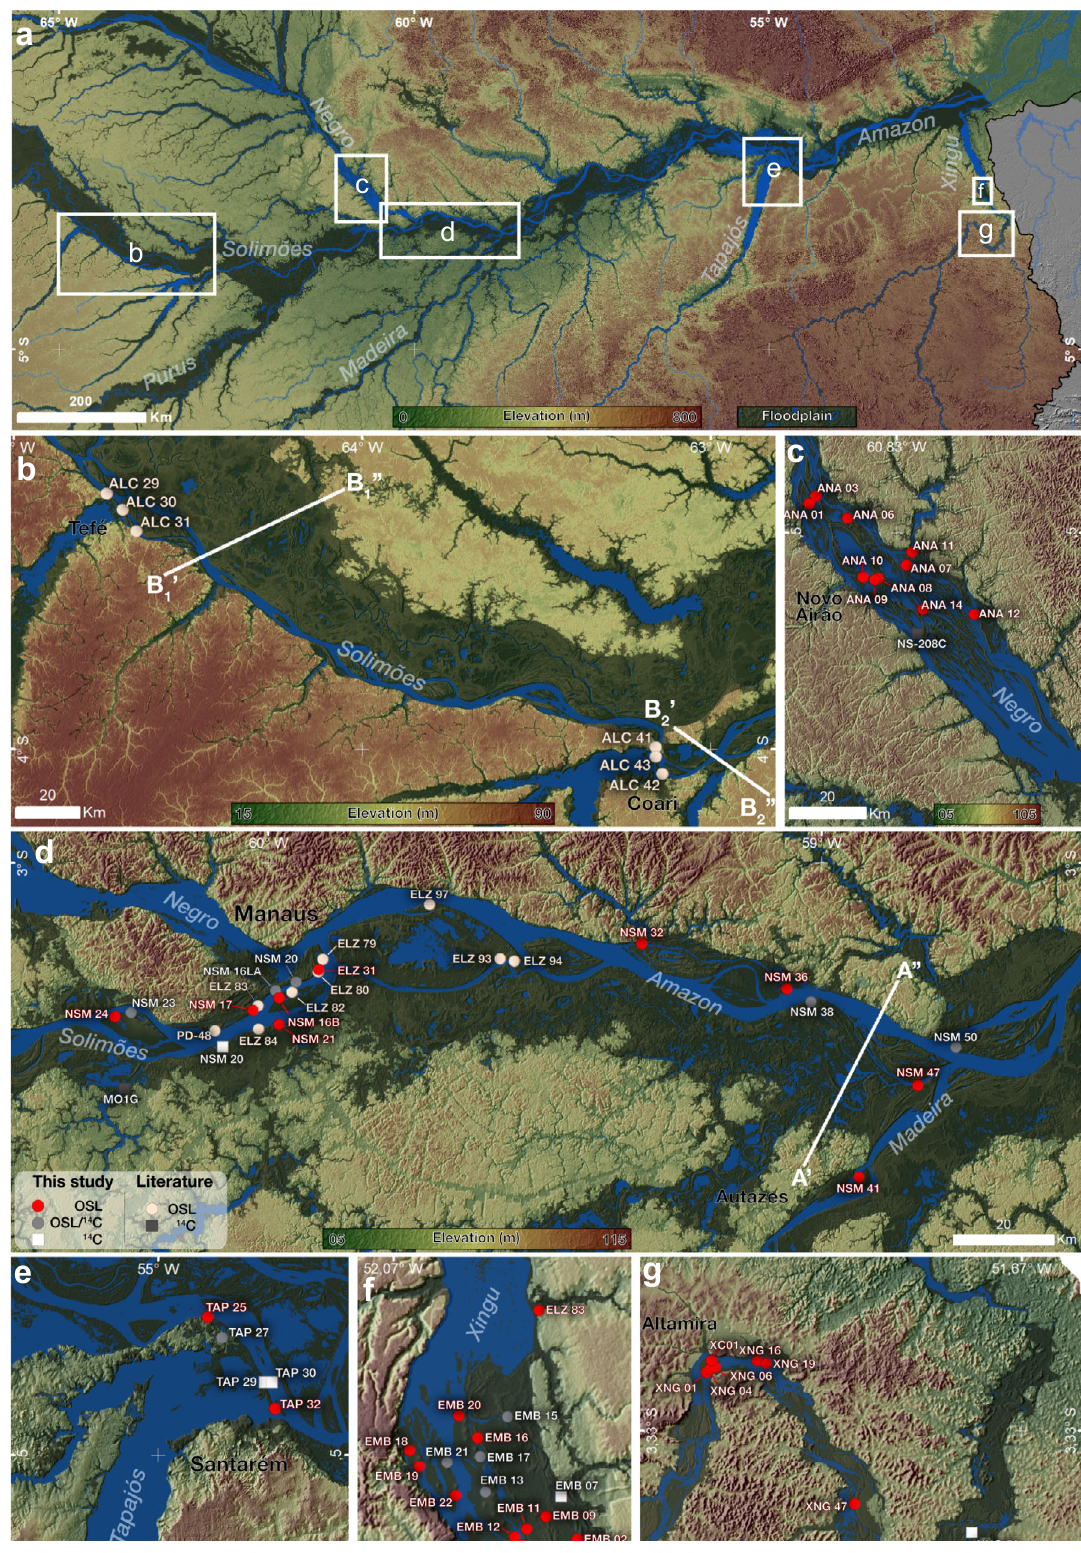
Fig.2|Seasonally fl oodedareas(ingreenshades)withintheSolimões-Amazon River valley and main tributaries in western, central and eastern Amazonia. Upland areas are shown in yellow-red shades. a White rectangles highlight areas sampledforOSLandradiocarbon( 14 C)datinginthisstudy.Elevationpro fi lesA ’– A ” , B 1 ’– B 1 ” and B 2 ’– B 2 ” are shown in Fig. 6. b Solimões River main stem between